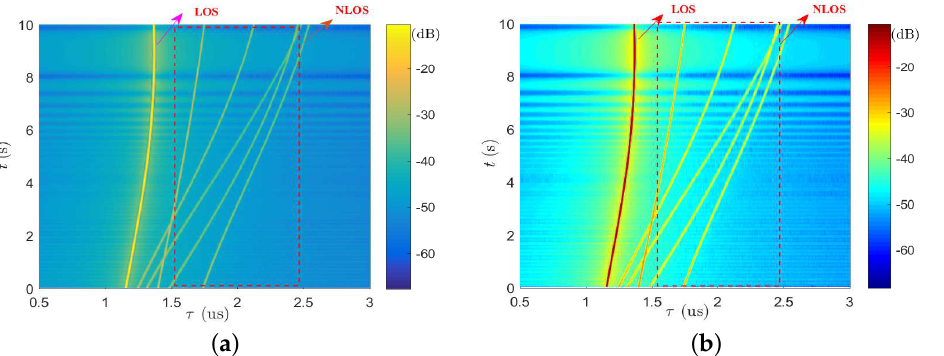
Figure 8. ( a ) The theoretical results of time-variant power delay profile (PDP) and ( b ) the measured time-variant PDP of proposed emulator.